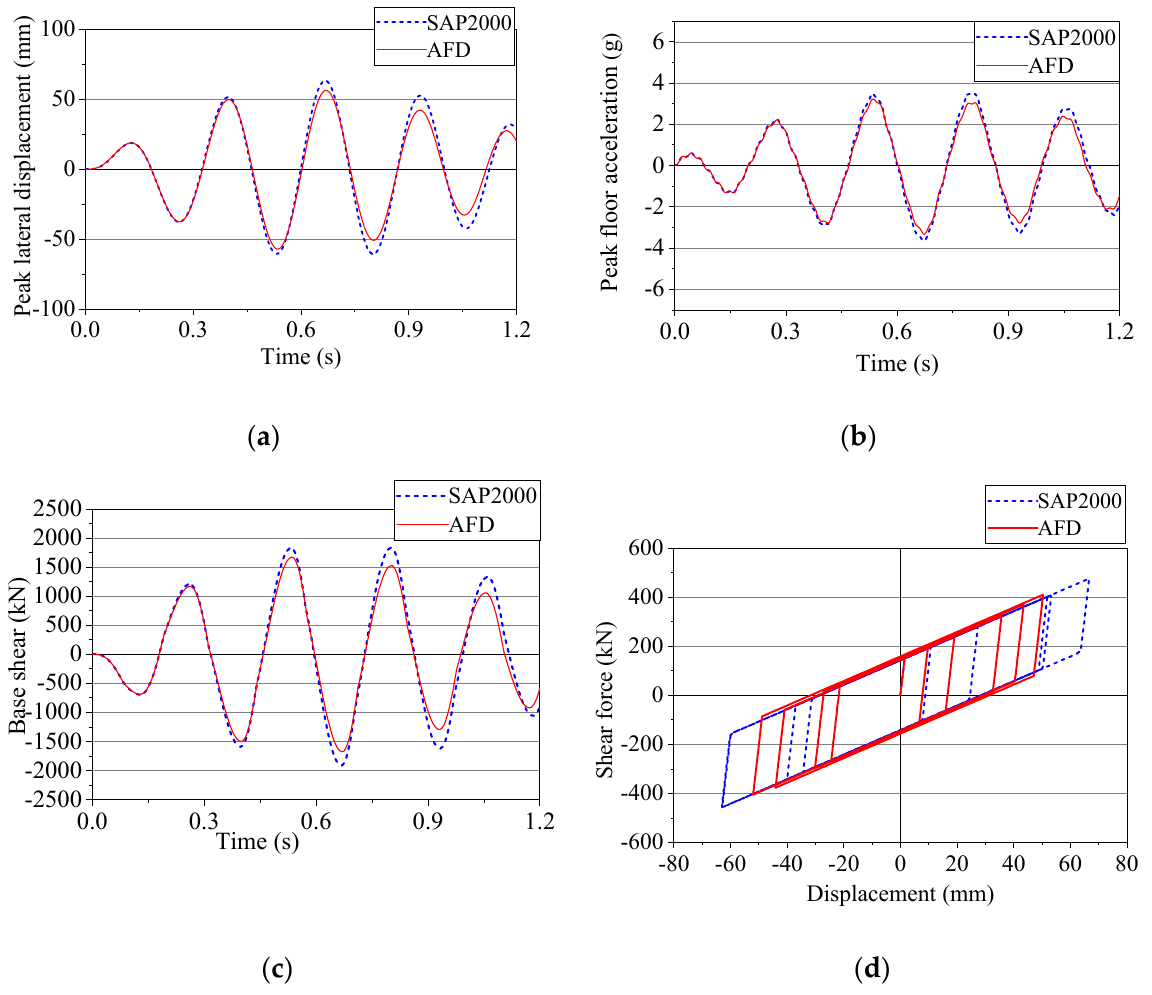
Figure 15. Responses of the frame under harmonic load P(t) with the period of sine wave of 0.2485 (s): ( a ) Peak lateral displacement; ( b ) Peak floor acceleration; ( c ) Base shear; ( d ) Hysteretic curve of energy dissipation device.